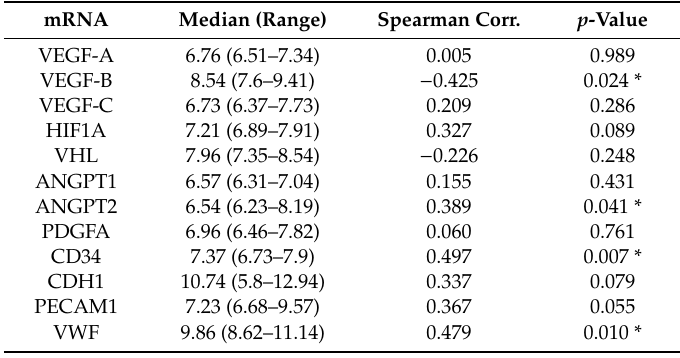
Table 2. mRNA expression of angiogenesis-related genes in relation to MVD ( n = 28).